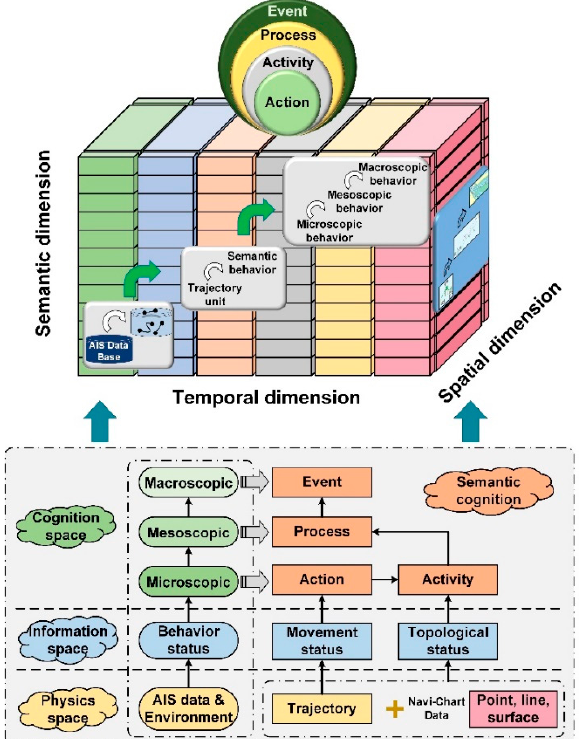
Figure 2. Representation process and construction model of ship multi-dimensional behavior.